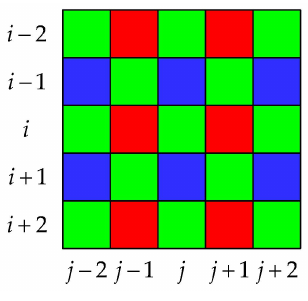
Figure 1. Bayer pattern